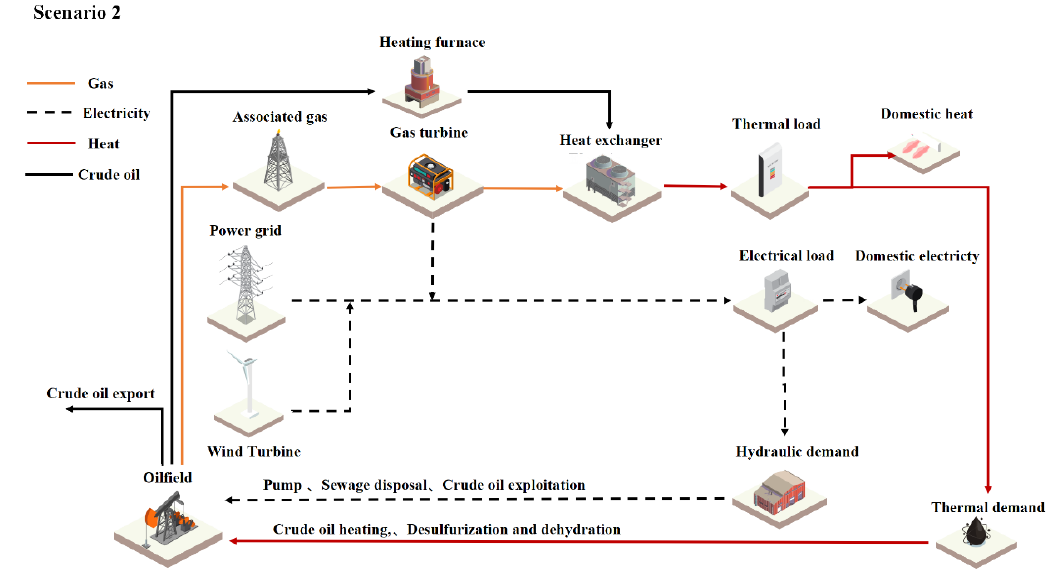
Figure 3. The oilfield energy system framework of scenario 2. (3)